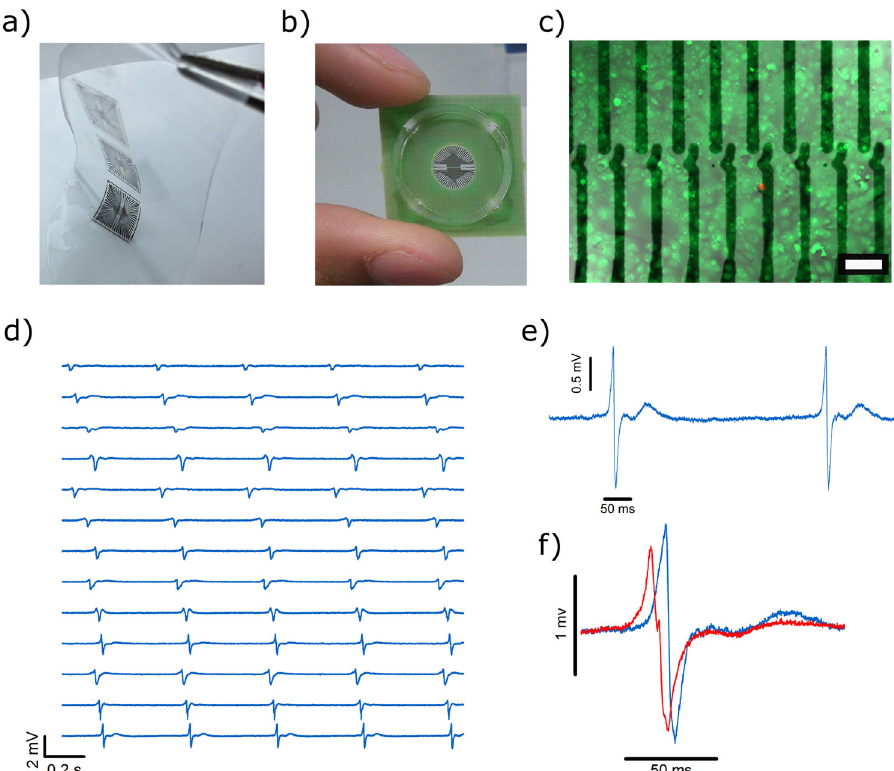
Fig. 3 Final device and demonstration of the printed MEAs on PDMS. a Photograph of printed carbon MEAs on a PDMS substrate. b Final chip bonded to a printed circuit board and encapsulated for use in cell culture. c Fluorescence microscopy image of live/dead staining of HL-1 cells growing on a PDMS MEA (scale bar 100 μm). Live cells appear green and a single dead cell red. d Action potential recording of different HL-1 cells growing on the same PDMS MEA over a time span of ∼ 2 s. e Magni fi ed display of a single recorded trace. f Overlay of two individual extracellular recordings. The temporal shift in the two signals indicates the signal propagation across the cell